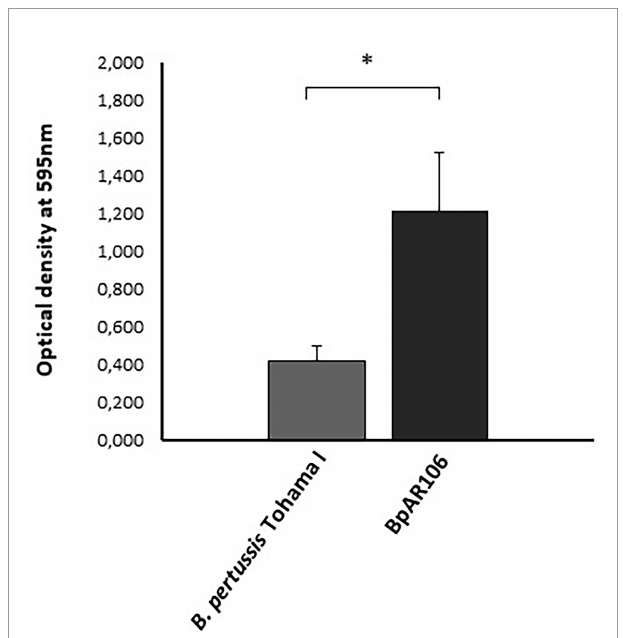
FIGURE 1 | Bio fi lm formation by B. pertussis Tohama I strain (gray column) and the clinical isolate BpAR106 (black column) on an abiotic surface. Bio fi lm biomass was quanti fi ed at 96 h of growth by staining with crystal violet and absorbance was measurement at OD 595 nm. Each value represents the mean from three independent experiments and the bars indicate standard deviation. Statistically signi fi cant differences in Student ’ s t-test between the clinical isolate and B . pertussis Tohama I biomass absorbance are indicated by * (p <